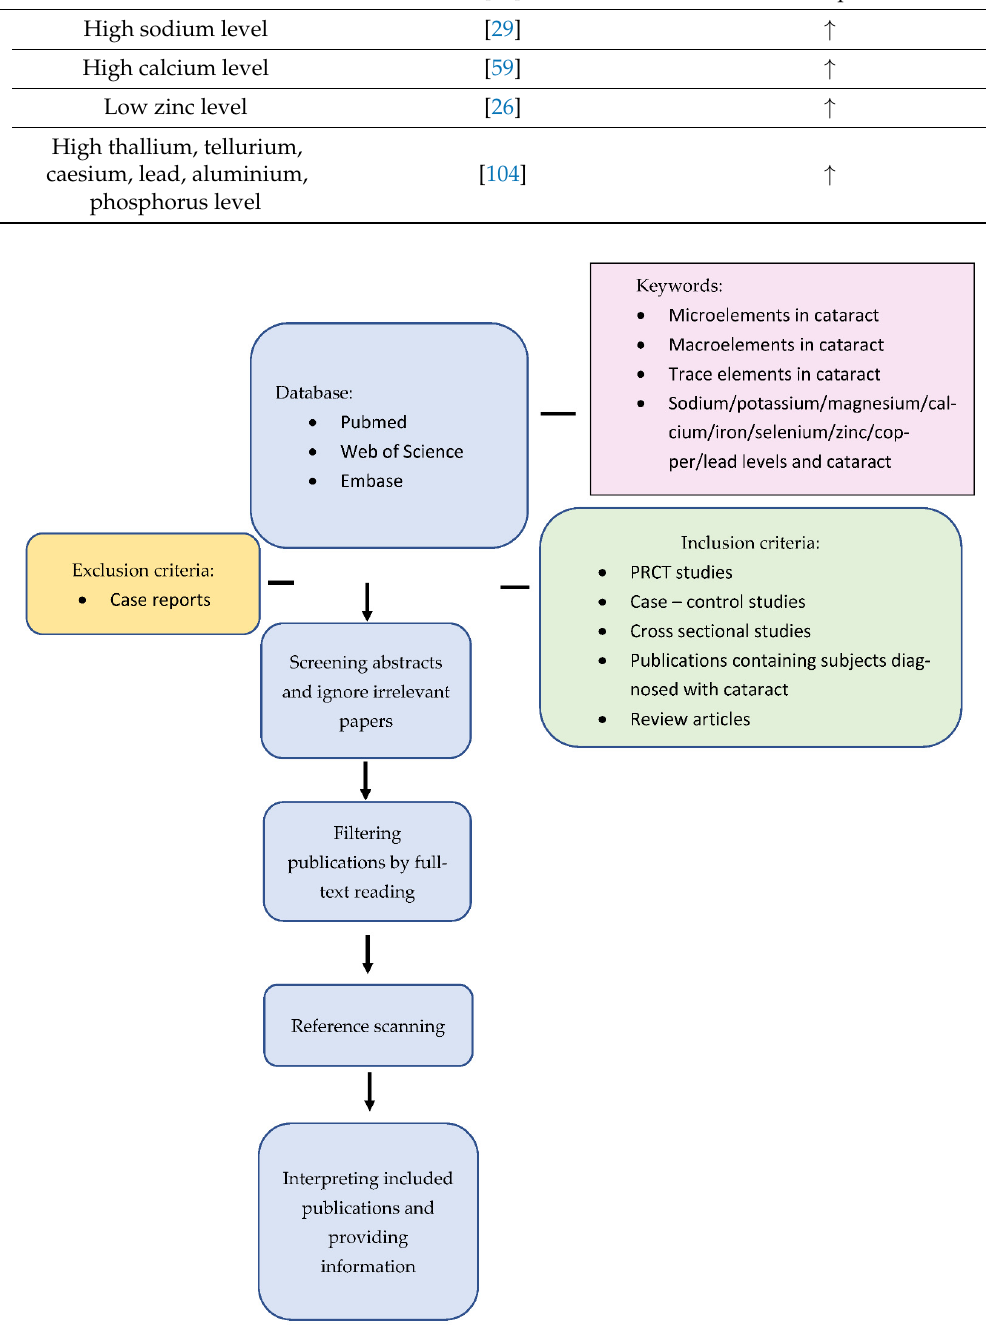
Figure 1. Flowchart showing the proposed approach.